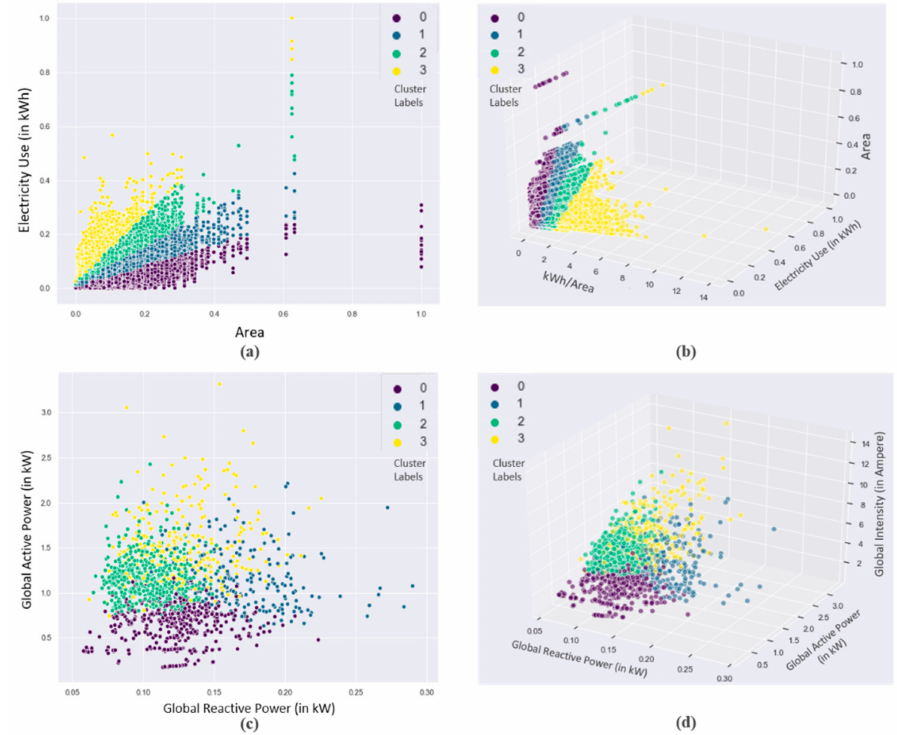
Figure 5. Clustering results of two datasets. ( a , b ) Residential DOE buildings dataset, ( c , d ) individual household dataset where each cluster is represented by a unique color based on di ff erent levels of